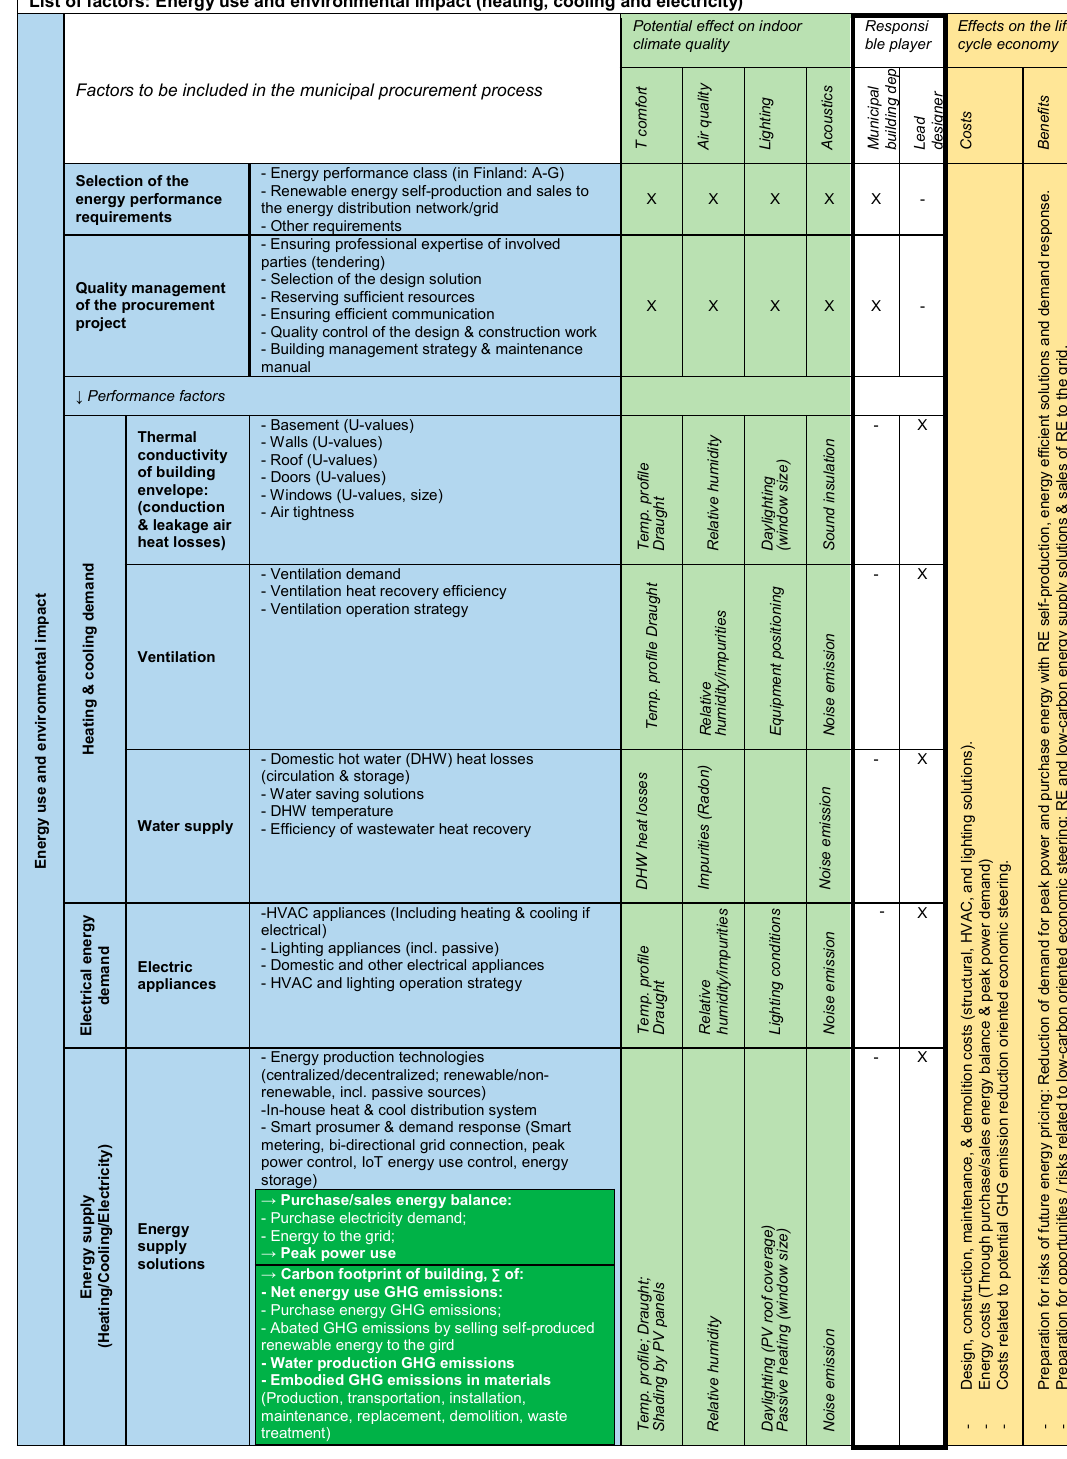
Figure 9. The energy efficiency responsibilities in the design of the municipal building: Energy use and the environmental impact of a building. Based on [10–14,27,36,41,43,46,47,50,53–59,65,67,79].